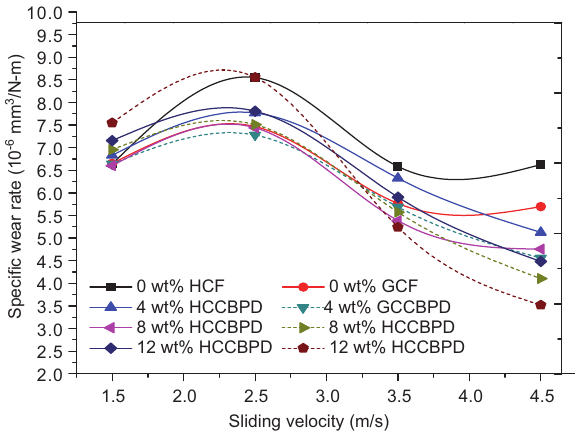
Figure 5 Variation of specific wear rate on sliding velocity of composites (constant sliding distance = 1 km, normal load = 10 N and abrasive medium = 18 μ